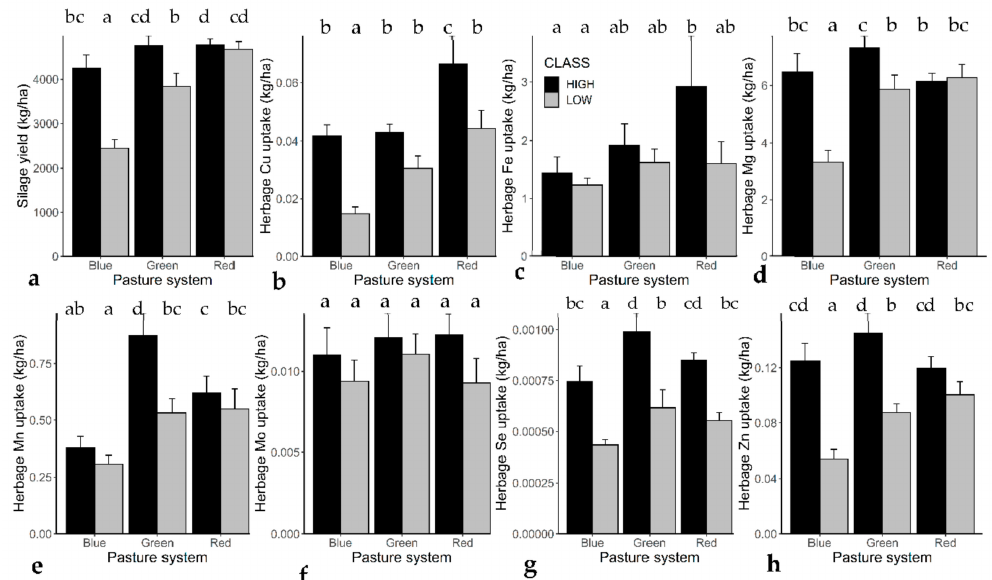
Figure 2. Mean (+SE) of ( a ) yield (boxed outline), and herbage uptake (nutrient concentration × yield) of ( b ) Cu, ( c ) Fe, ( d ) Mg, ( e ) Mn, ( f ) Mo, ( g ) Se and ( h ) Zn at locations selected as high (black) or low (grey) soil total micro-nutrient content; M and 8 low locations in each of the pasture systems: high-sugar grass + legume mix − N fertilizer (blue/HSG + L), permanent pasture + N fertilizer (green/P + N), high-sugar grass + N fertilizer (red/HSG + N). Letters above indicate significant differences at p <